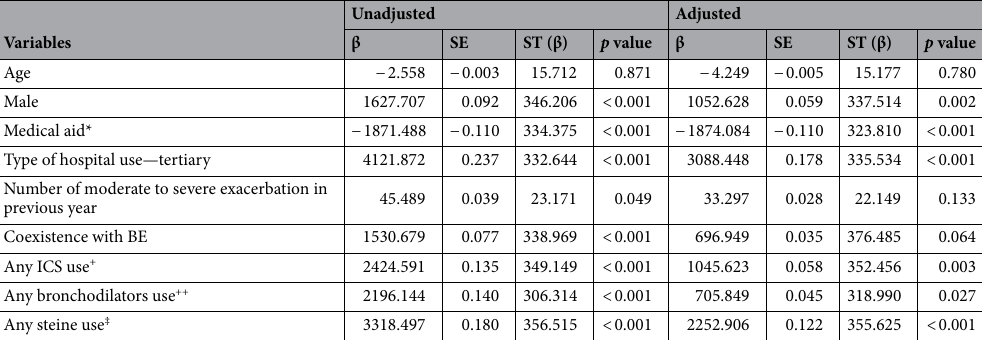
Table 5. Factors affecting medical costs (USD). Data are expressed as mean ± standard deviation or N (%). *Patients with low socioeconomic status were covered by medical aid in Korea. + Any ICS use included ICS only and ICS plus LABA. ++ Bronchodilator included LAMA, LABA. ‡ Any steine included erdosteine, acetylcysteine, and carbocysteine.